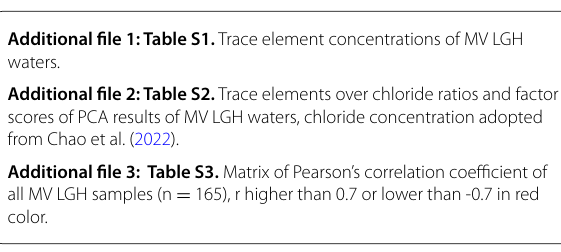
Additional file 2: Table S2. Trace elements over chloride ratios and factor scores of PCA results of MV LGH waters, chloride concentration adopted from Chao et al. (2022). Additional file 3: Table S3. Matrix of Pearson’s correlation coefficient of all MV LGH samples (n 165), r higher than 0.7 or lower than ‑0.7 in red =